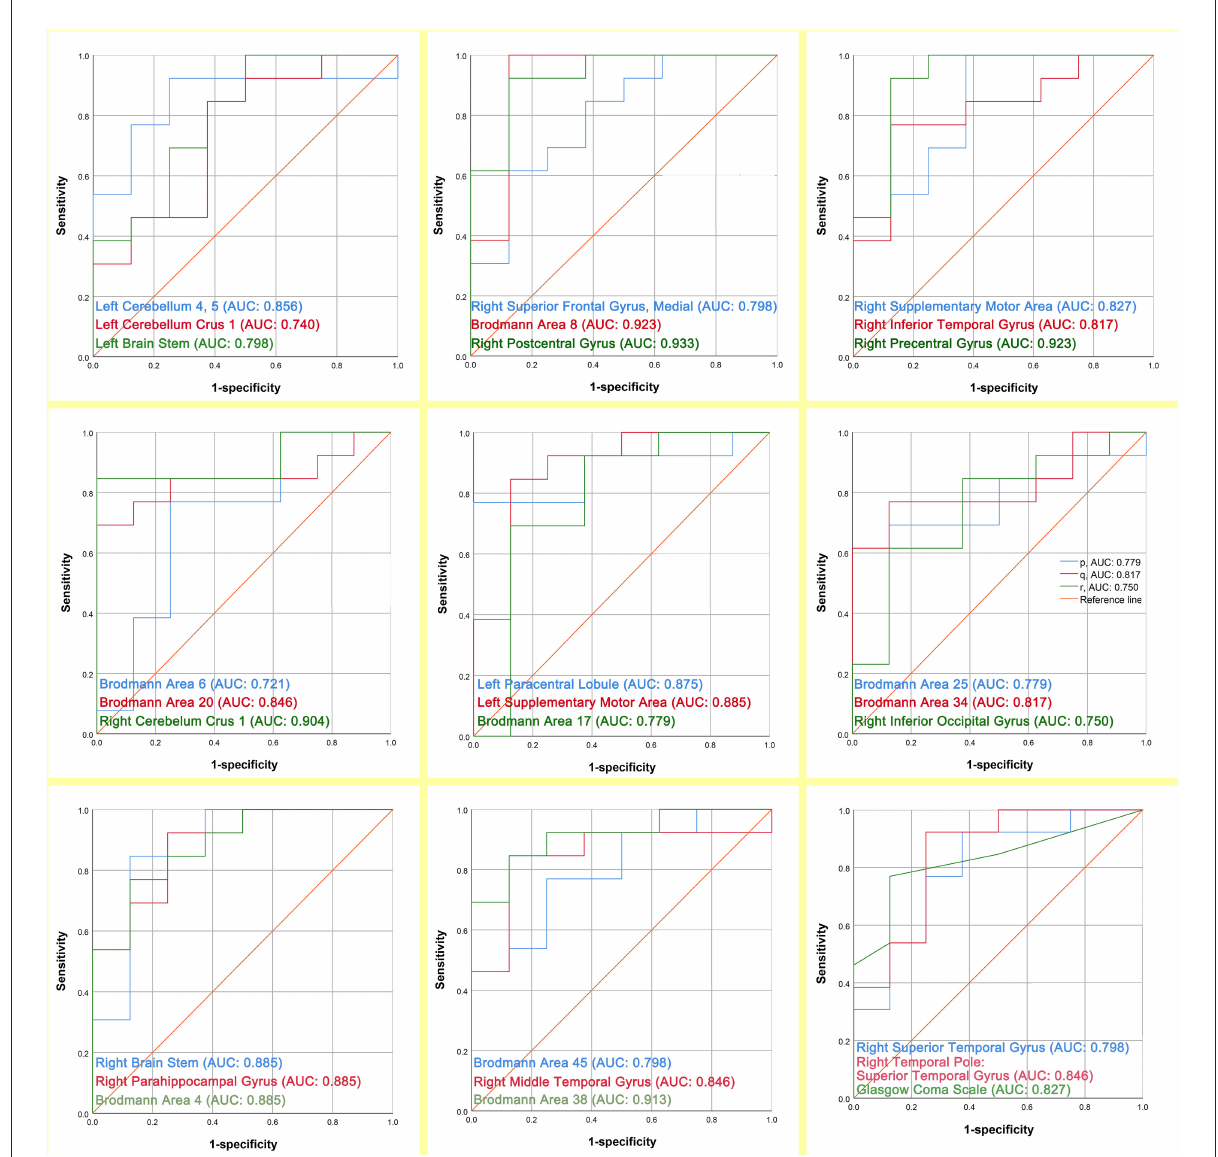
FIGURE5 The prognostic assessment ability of the 26 regions of interest and GCS respectively for the outcome of DOC patients (AUC: area under the